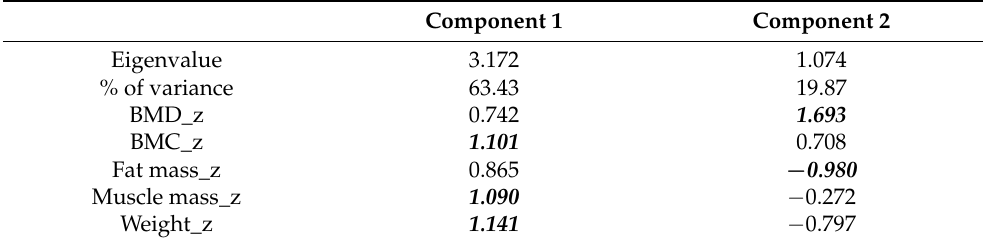
Figure 2. Z profile (mean of z-scores) of structural parameters in female athletes; BMC in grams and fat and muscle mass in kilograms were expressed as a percentage of height in meters. Table 4. Results of the principal components analysis (Cronbach’s alpha: 0.946, bold and italic represent the absolute amount of the component